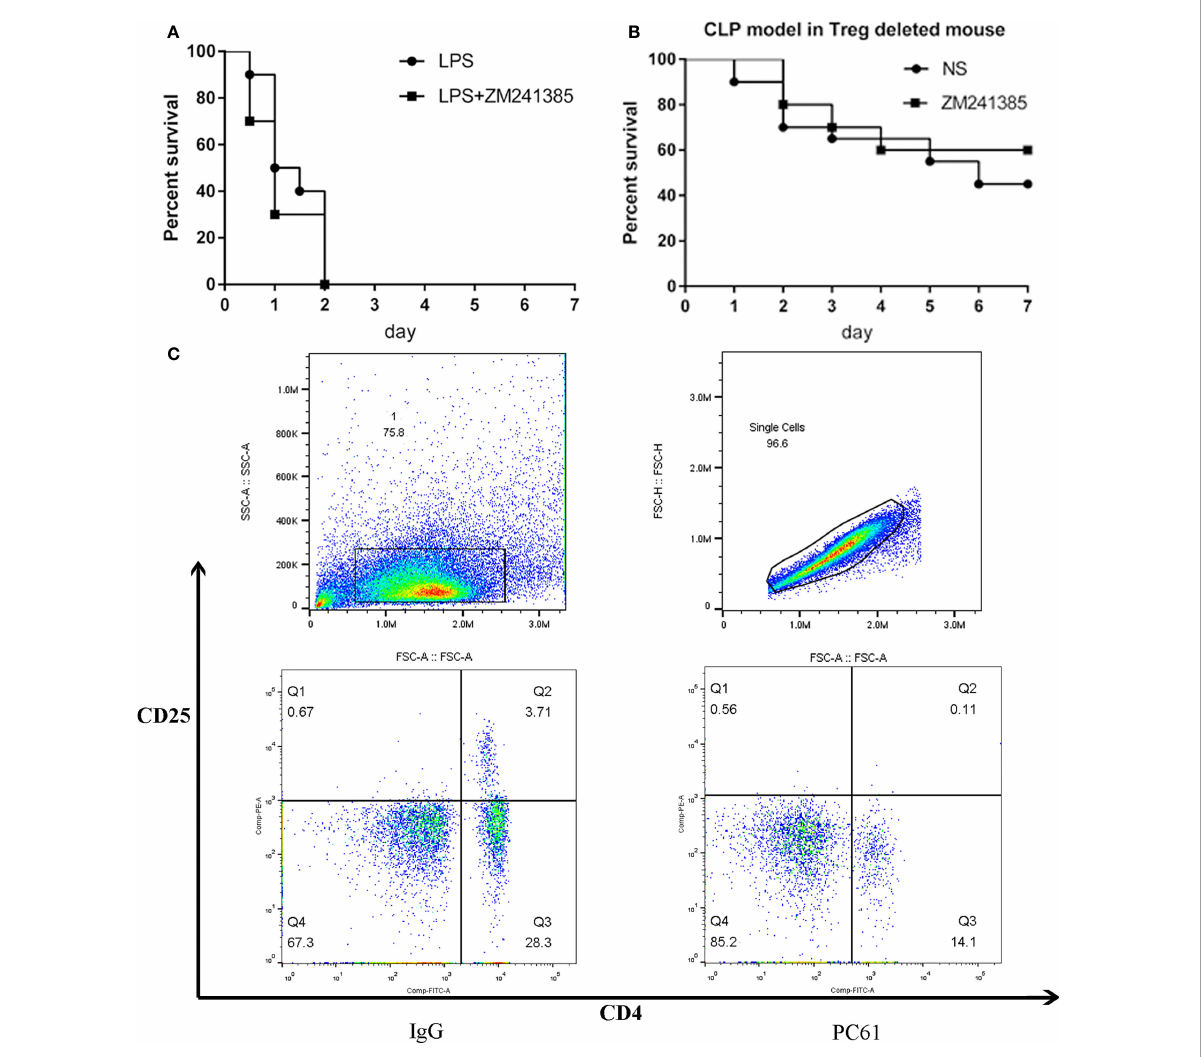
FIGURE 2 ZM241385 (5 mg/kg) did not improve LPS-induced sepsis survival and CLP-induced sepsis survival in Tregs deleted mice. (A) The LPS induced sepsis model was administrated by a single intravenous injection of LPS (1 mg/kg). Mice were subjected to LPS or ZM241385+LPS (n = 10 per group). The survival rates were evaluated for a consecutive 7 days after CLP. (B) To deplete Tregs in vivo, 100 m g of anti-CD25 antibody (Clone PC61) was injected intravenously one day before the CLP model. Rat IgG was injected into the control mice. The effect of deletion is con fi rmed by Flow Cytometry. Septic mice were subjected to normal saline (NS) or ZM241385 (n = 10 per group). (C) The survival rates were evaluated for a consecutive 7 days after CLP. A statistical difference was determined by the log-rank